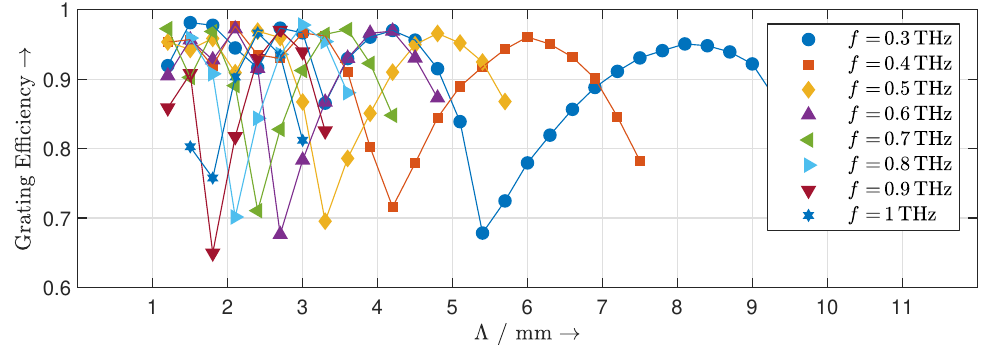
Figure 10. Diffraction grating efficiency of the MEMS reflection gratings for different grating periods at different frequencies.